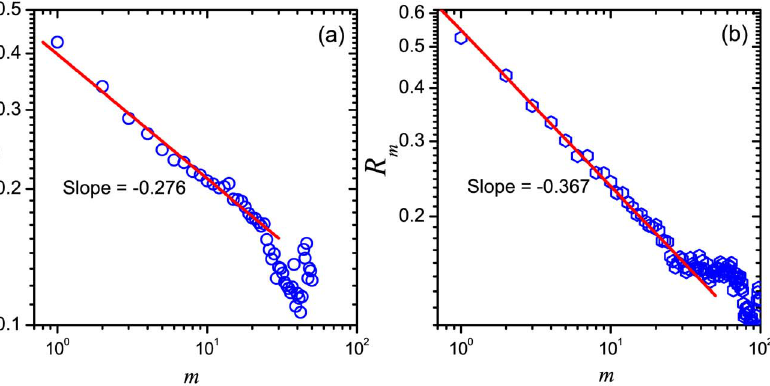
Figure 5. Long-term correlations in human mobility. (a) The decay of Kendall’s Tau t K between ~ dd i and ~ dd i z m as a function of the interval m . (b) Pearson correlation coefficient R m between log ( ~ (cid:2) dd (cid:2) dd i ) and log ( ~ (cid:2) dd (cid:2) dd i z m ) as a function of the interval m .